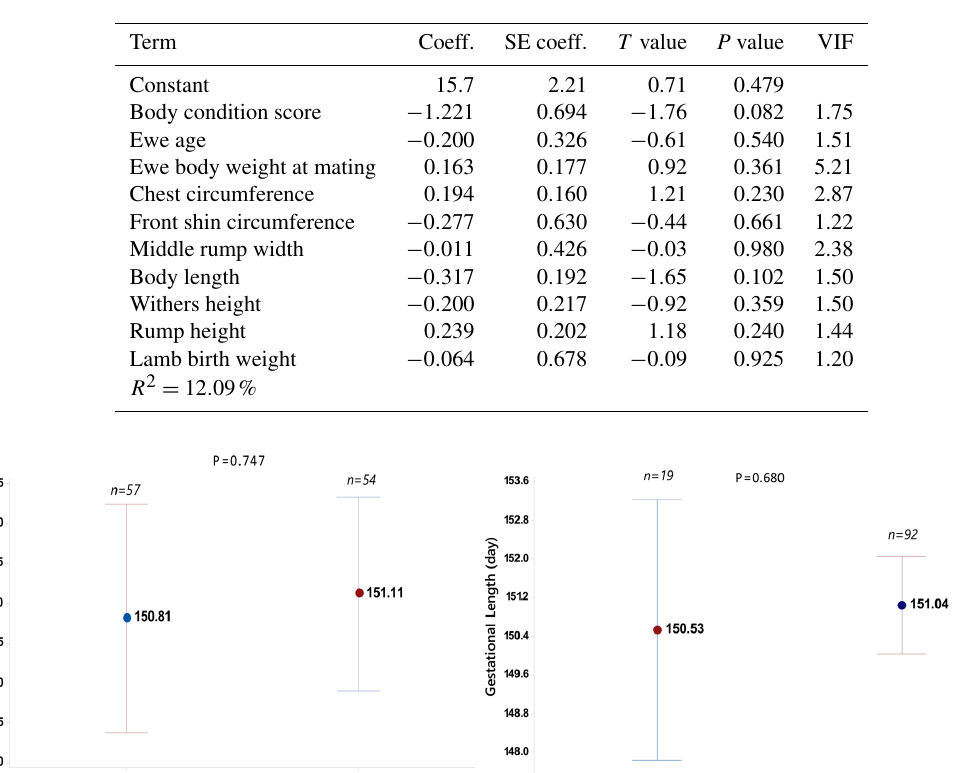
Table 3. Regression coefficients for gestational length. SE refers to standard error, and VIF refers to the variance inflation factor.